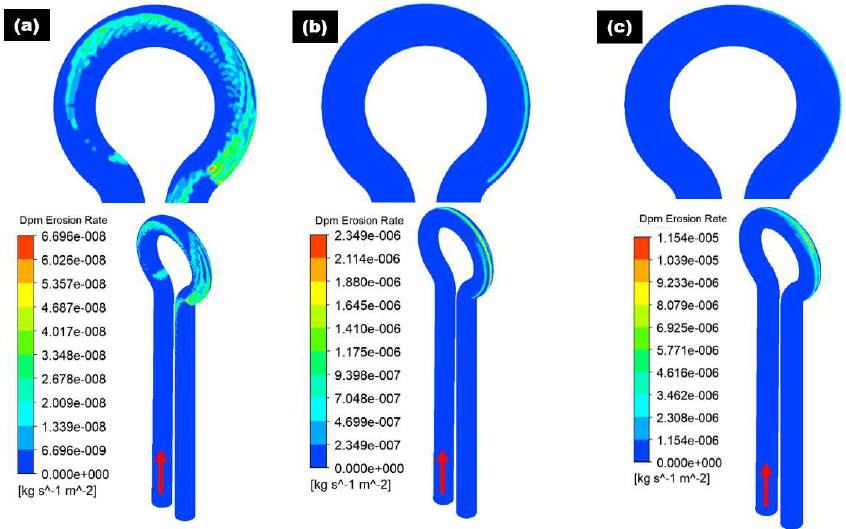
Figure 6. Erosion distribution in double offset U−bend: ( a ) 2 m/s; ( b ) 4 m/s; ( c ) 6 m/s.